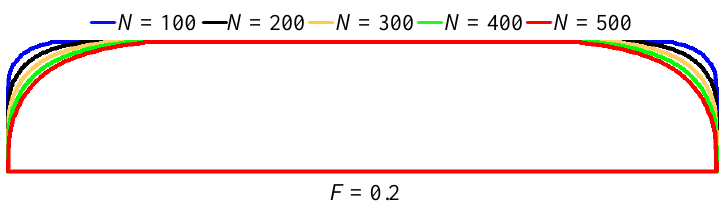
Figure 3. Detection points setting of the B .